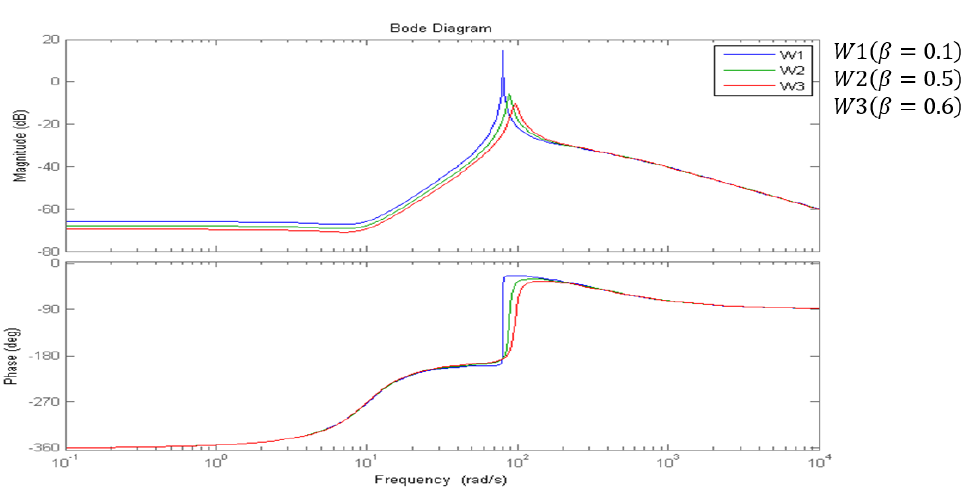
Figure 11. Frequency characteristics of the drive based on the traction motor. 4. Analysis of Self-Oscillations According to the results of experiments on tracks 1–3, it should be noted that at small slopes of the track (and, accordingly, drive loads), current self-oscillations are not ob- served. From this it should be concluded that it is the load torque and slip that change the transfer function of the system in such a way that self-oscillations occur, which are signif-